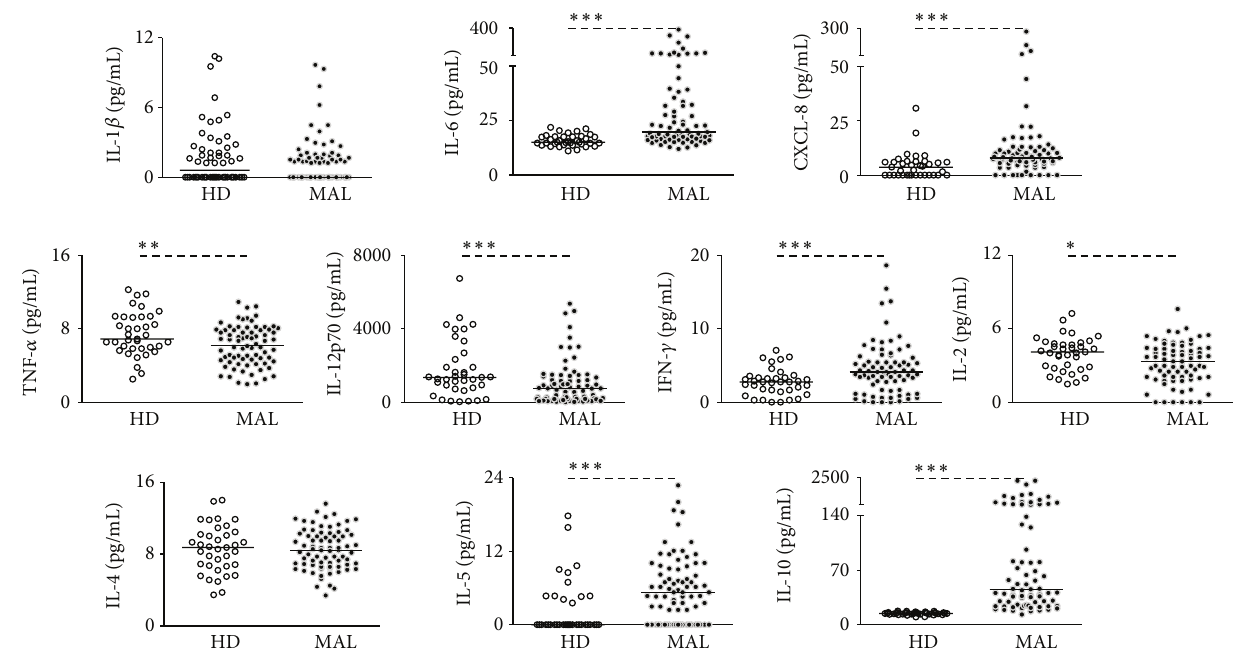
Figure 1: High levels of IL-6, CXCL-8, IFN- 𝛾 , IL-5, and IL-10 are found in the circulation of patients infected with P. vivax . The biomarkers IL-1 𝛽 , IL-6, CXCL-8, TNF- 𝛼 , IL-12p70, IFN- 𝛾 , IL-2, IL-4, IL-5, and IL-10 were measured in the serum of healthy donors (open circles) and P. vivax -infected subjects (closed circles). Levels of biomarkers were measured employing ELISA or Cytometric Bead Array